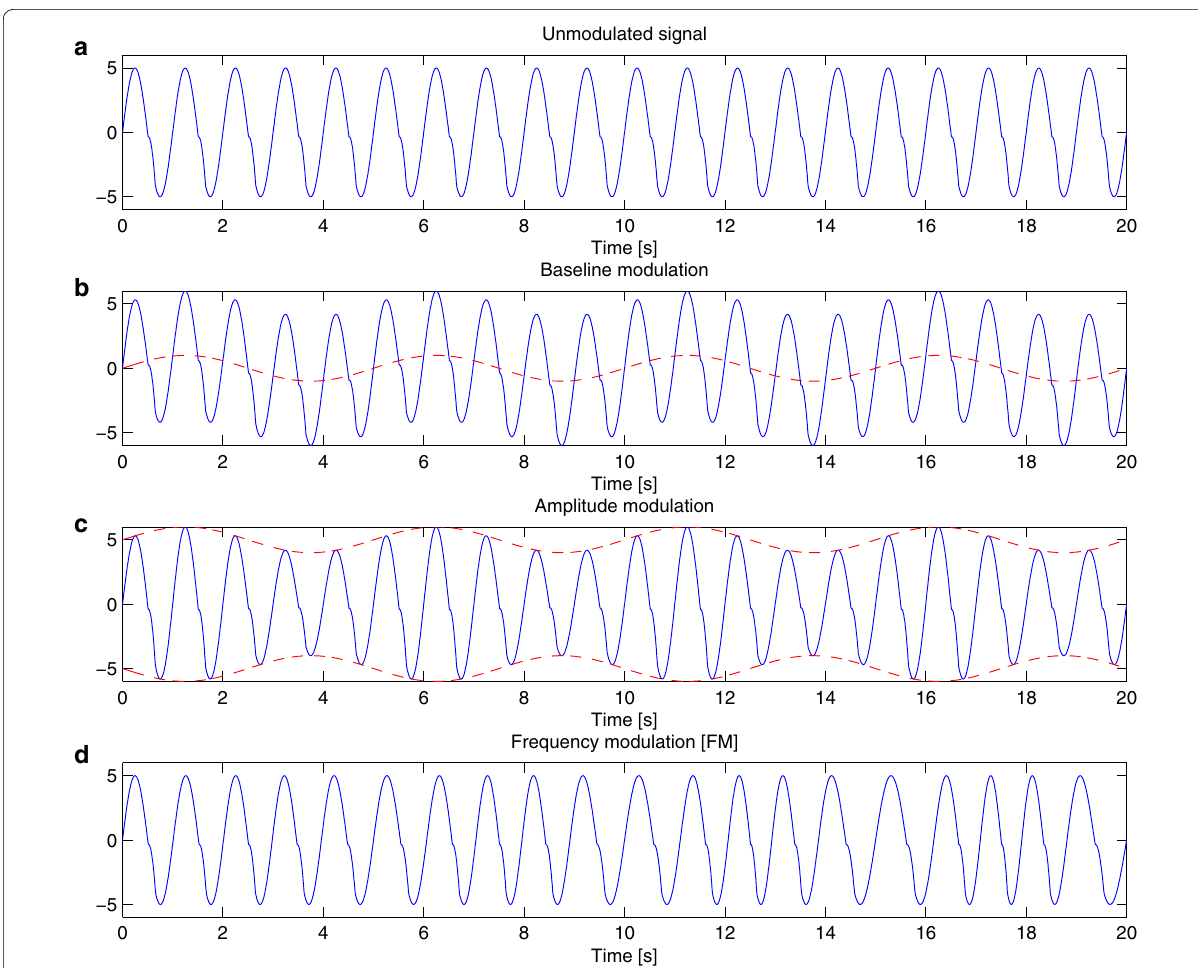
Fig. 3 Three principal types of respiratory modulation of the plethysmogram signal (PPG) that are used for respiratory rate estimation. a Unmodulated PPG waveform. b Baseline modulation [BM]; the red dashed line depicts the baseline modulation related to the respiratory rate component. c Amplitude modulation (AM); the two red dashed lines depict the signal envelope related to the respiratory rate component. d Frequency modulation (FM); this modulation of the heart rate, also called “respiratory sinus arrythmia”, is synchronized with the respiratory